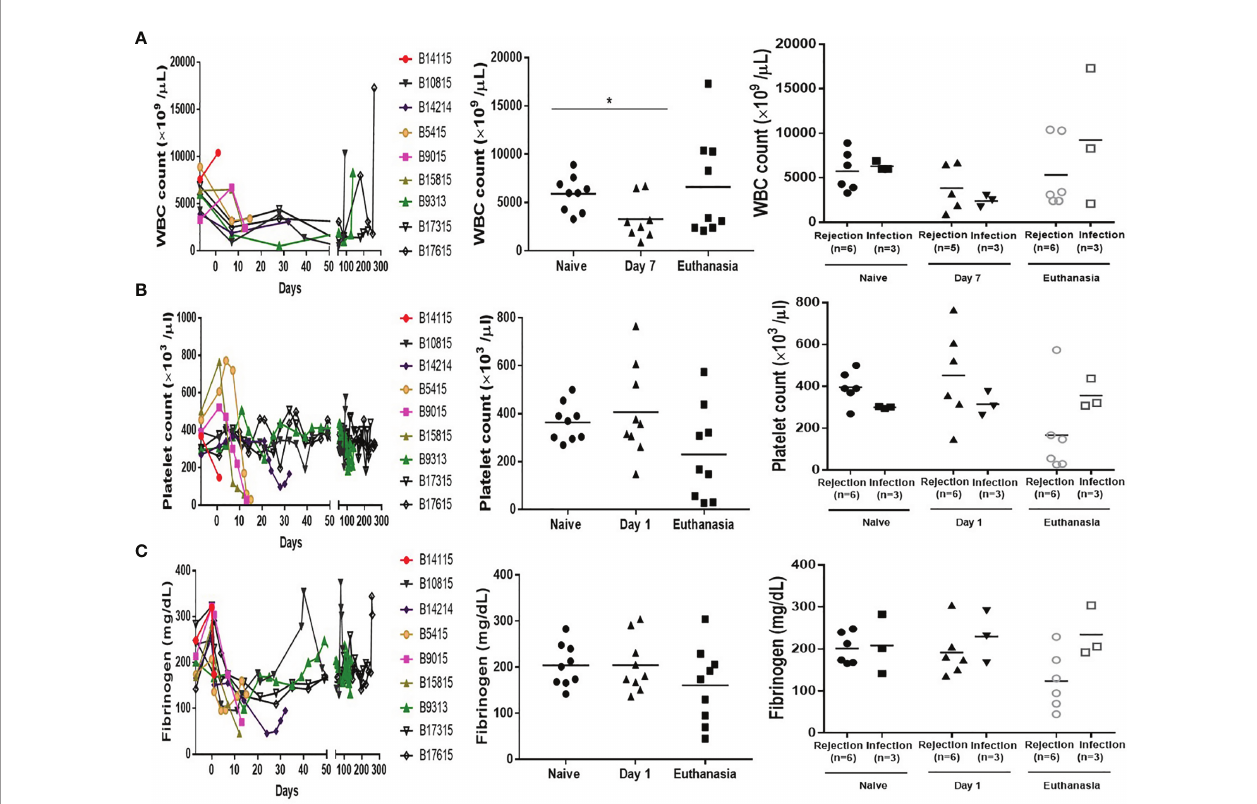
FIGURE 3 | White blood cell and platelet counts, and plasma fi brinogen levels in baboons with pig kidney grafts. (A) WBC counts in the baboons (n=9) at different time-points (Left); The difference in the WBC count in the baboons (n=9) (Middle), and between the rejection (n=6 or 5) and infection (n=3) groups at pre-Tx (naïve), day 7 after operation, and at euthanasia (Right). (B) Platelet counts in the baboons (n=9) at different time-points (Left); The difference in the platelet count in the baboons (n=9) (Middle), and between the rejection (n=6) and infection (n=3) groups at pre-Tx (naïve), day 1 after operation, and at euthanasia (Right). (C) Plasma fi brinogen in the baboons (n=9) at different time-points (Left); The difference in the plasma fi brinogen in the baboons (n=9) (Middle), and between the rejection (n=6) and infection (n=3) groups at pre-Tx (naïve), day 1 after operation, and at euthanasia (Right). (*p <